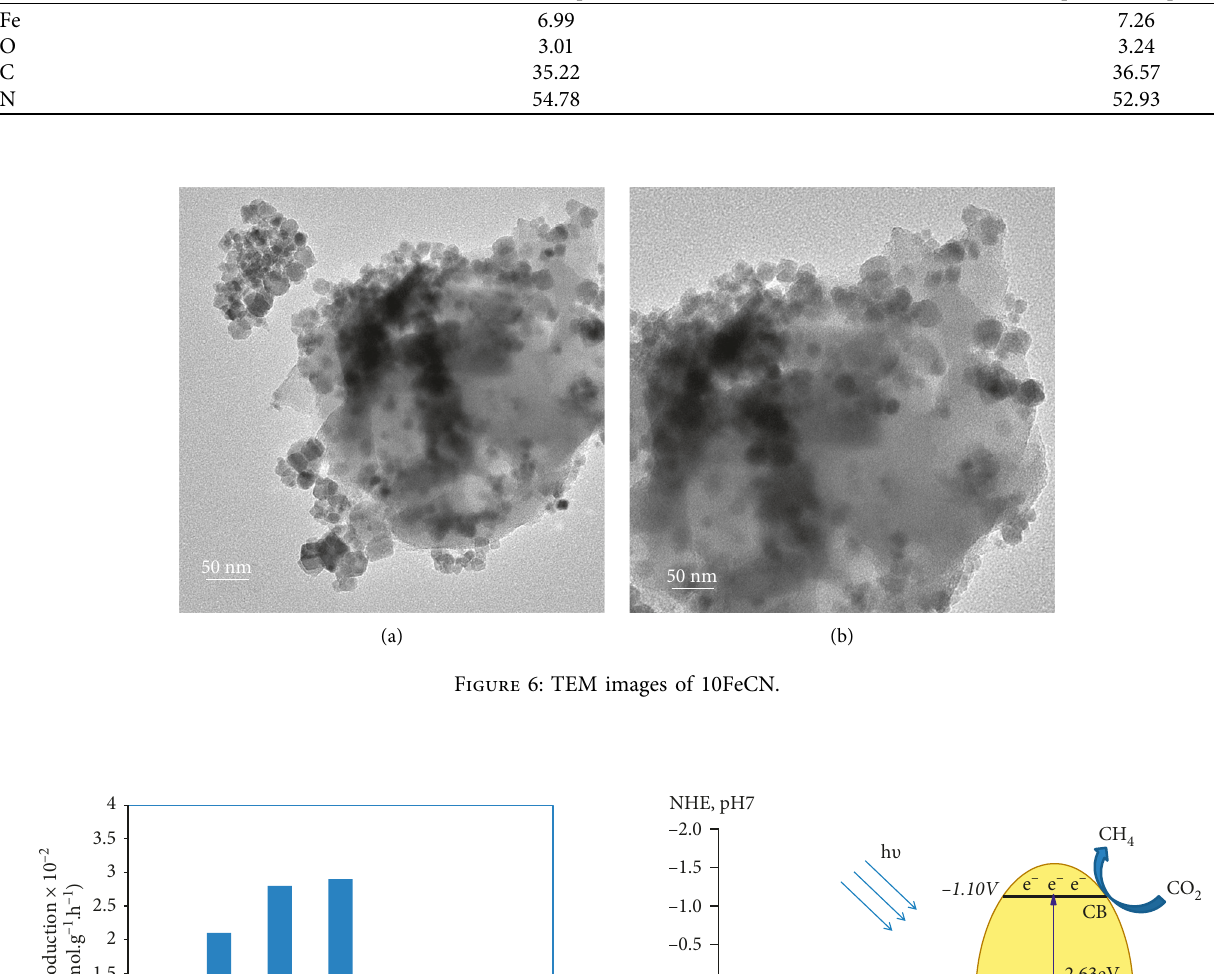
Table 1: Weight percentages of different elements in the composition of 10FeCN. Element